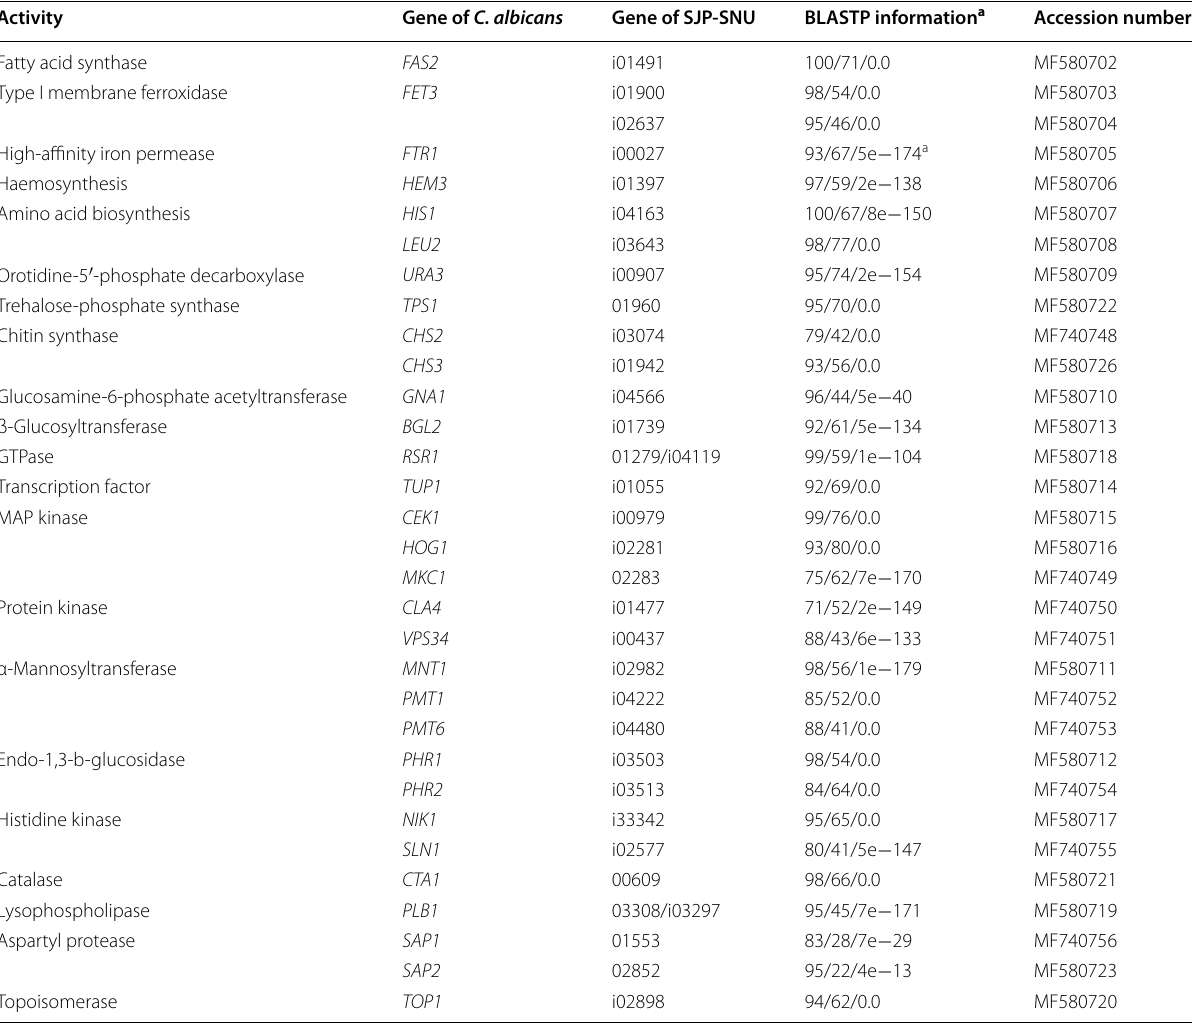
Table 4 Pathogenicity-related genes of